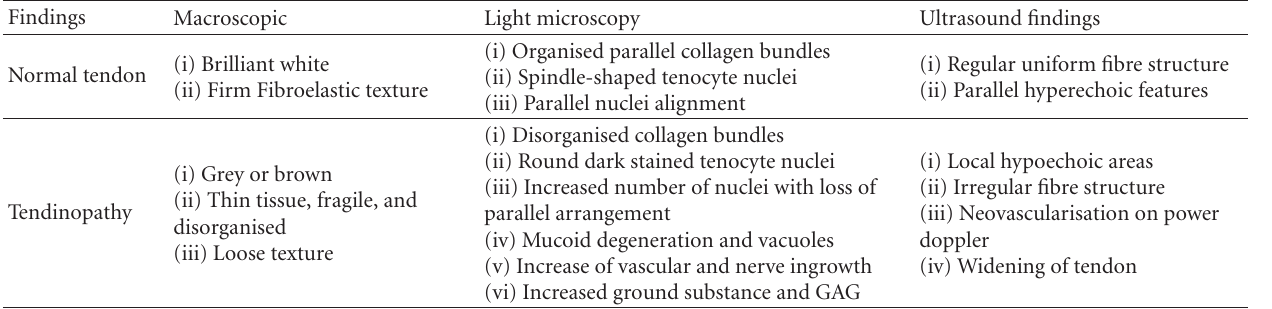
Figure 1: The biology of heat shock proteins in inflammatory disease. Tissue damage/stress results in the release of alarmins which in turn signal via the highlighted receptor complexes. HMGB1 and IL-33 also have intracellular nuclear functions when upregulated. This results in the release of further cytokines, growth factors, and changes in extracellular matrix production within the damaged tissue with pathological changes. Table 1: Key pathological features of